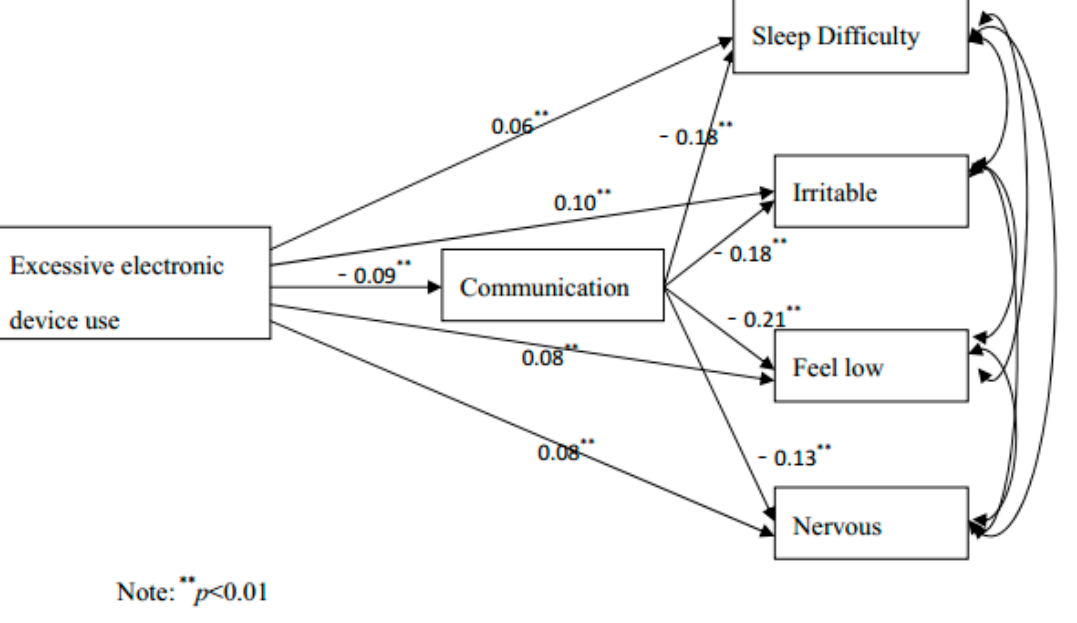
Figure 3. The mediation model showing the mediator role of parent–adolescent communication between excessive electronic device use and each psychological symptom.